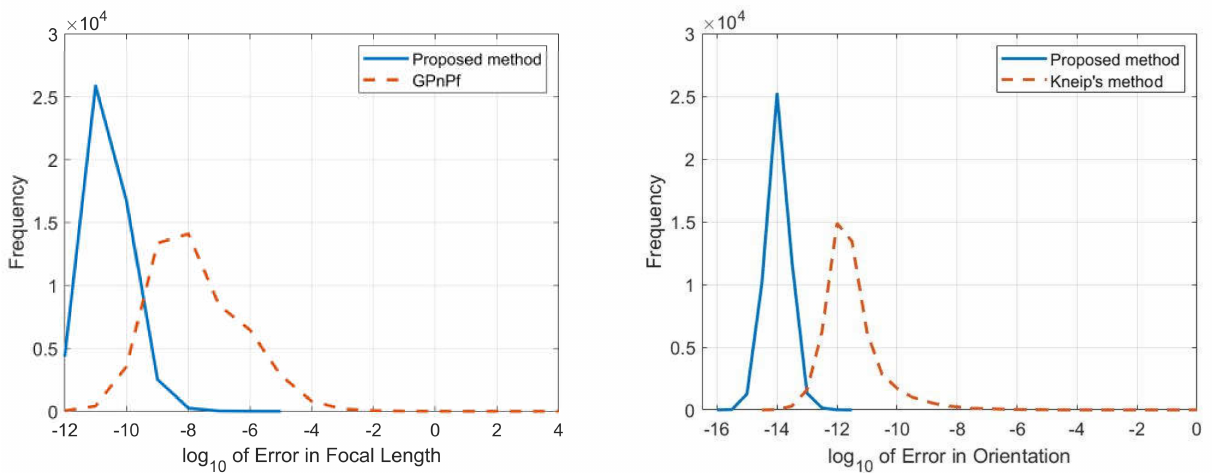
Figure 9. Relative error in focal length ( left ) and error in orientation ( right ) for our proposed method (blue) and the other methods (yellow).